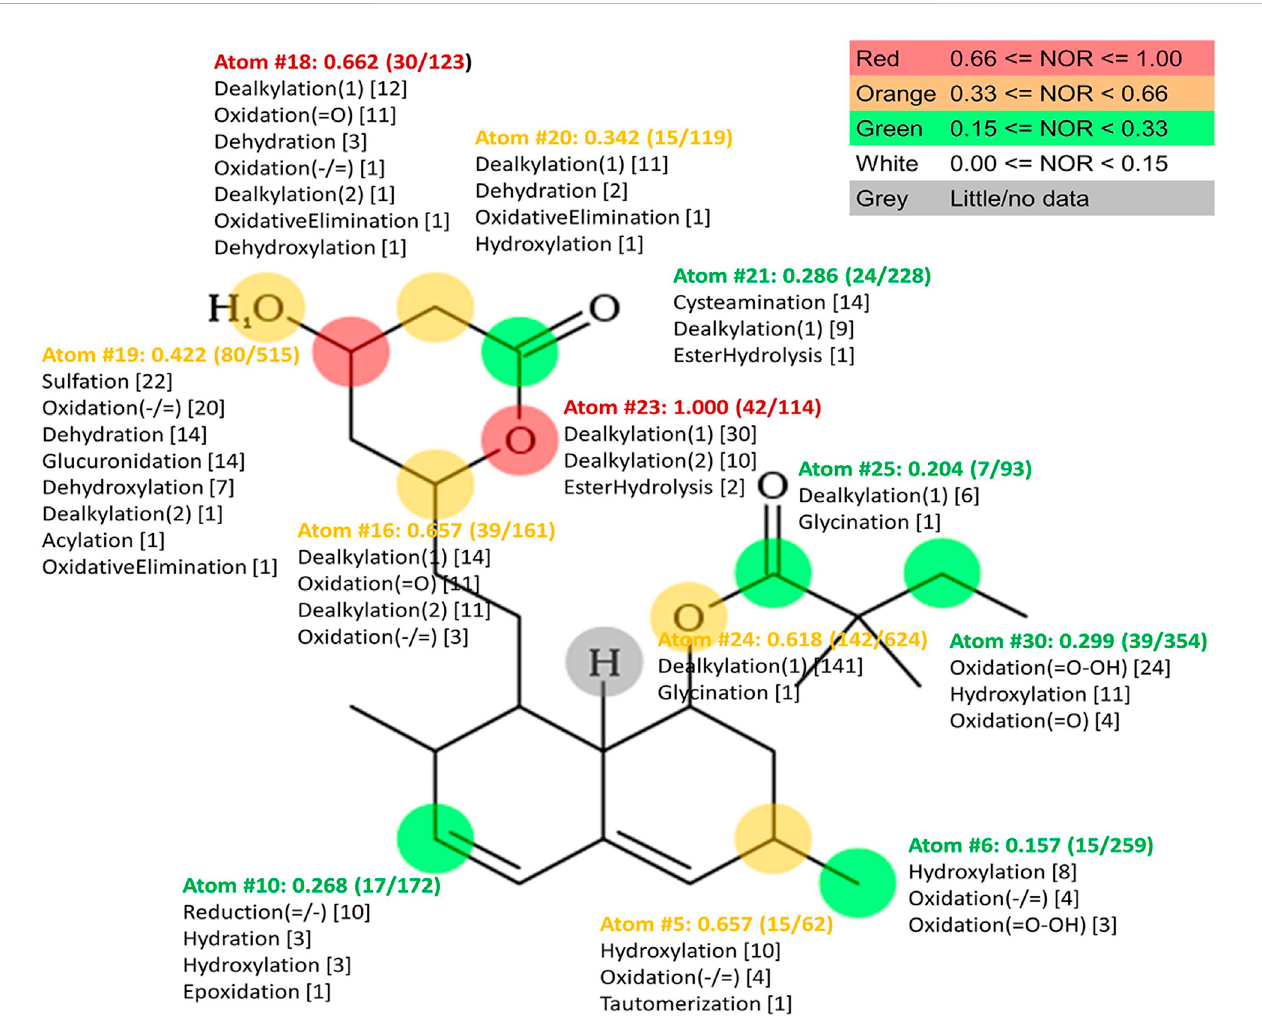
FIGURE 3 Plot of MetaPrint2D predictions. Atoms which are most likely to be biotransformed and reactions predicted by Meta Print2D are marked. NOR value for each marked atom is assigned indicating the probability of predicted reaction occurring. The most likely metabolic reaction sites are atoms with the highest NOR value which are colored in